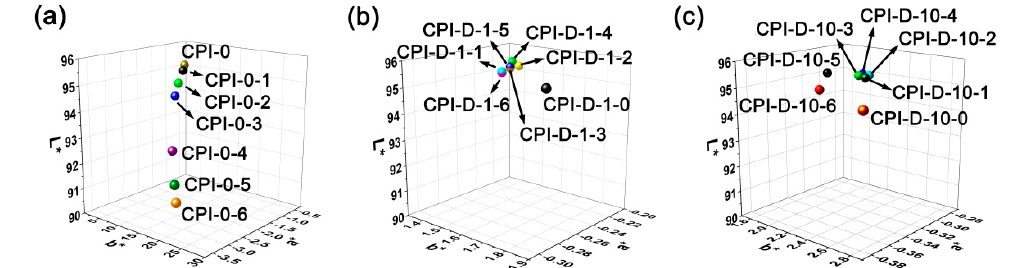
Figure 12. Three-dimensional (3D) CIE Lab parameters of CPI-0 and CPI-D nanocomposite films after Xenon lamp exposure. ( a ) CPI-0; ( b ) CPI-D-1; ( c ) CPI-D-10. Table 5. Optical properties of CPI/791 nanocomposite films after Xenon lamp exposure for 6 h. T 350, Xe 1 haze Xe 2 CPI Samples L * Xe 2 b * Xe 2 (%) (%)